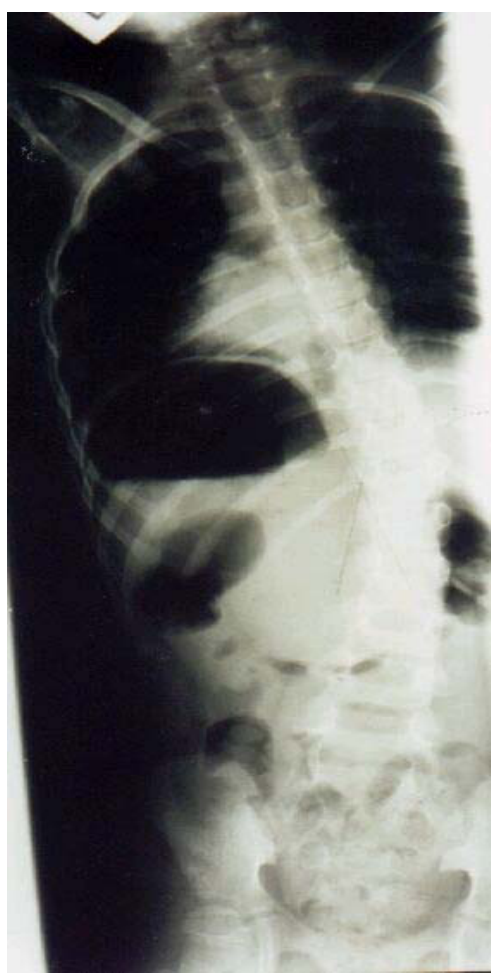
FIGURE 1 . A 29º Cobb right C-shaped scoliosis taken in a supine position on August 2,